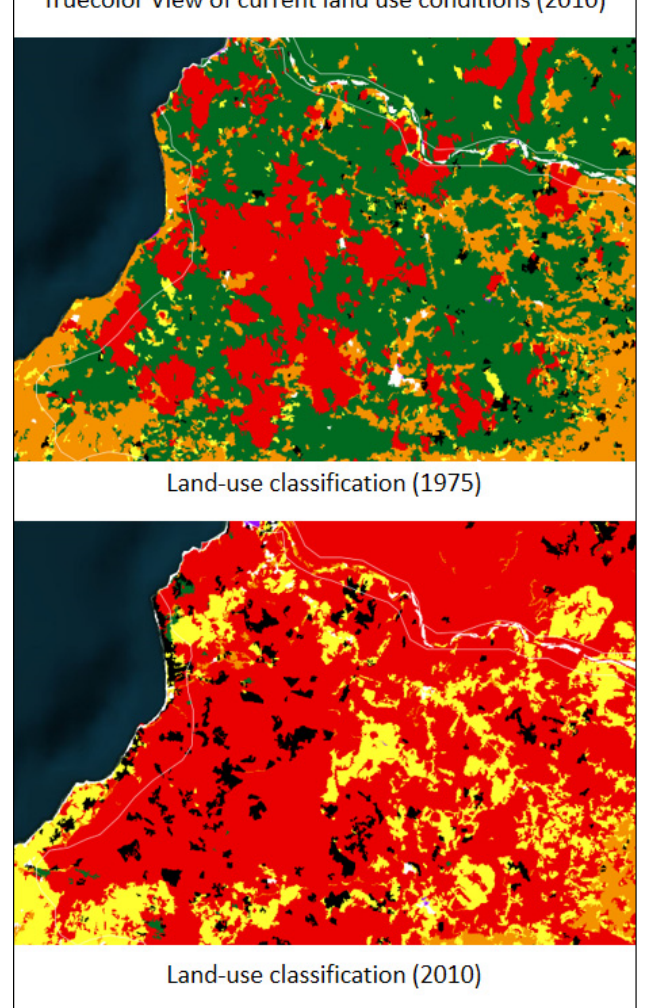
Figure A9. Overview of the area in the northern study area (small white inset in Figure 3). This section shows the land use change particularly clearly. It shows the area where plantations were already present in 1975. These are some of the first plantations estab.